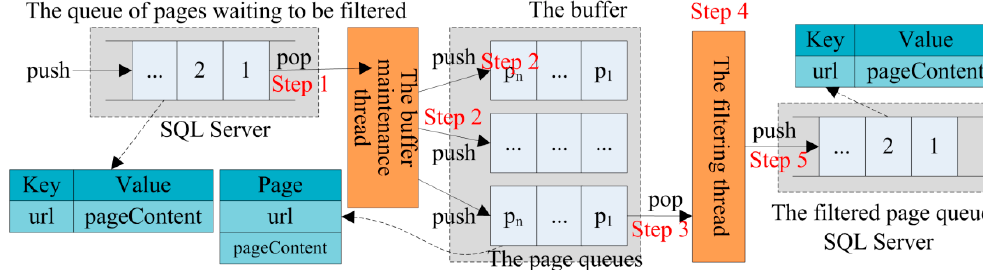
Figure 2. The software design.